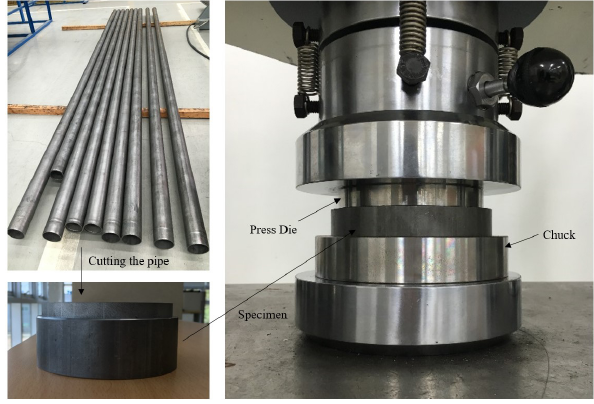
Figure 9. Shear strength test specimen and shear strength